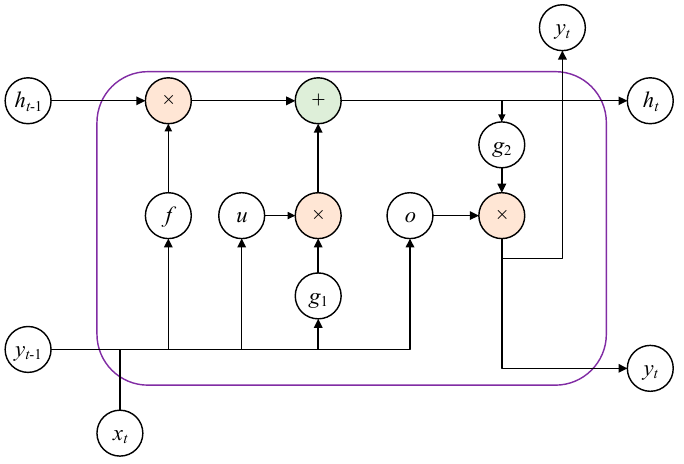
Figure 1. Structure of the long short-term memory (LSTM) network.